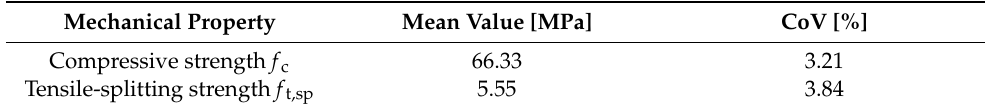
Table 2. Tested material properties of the concrete used in all tests. These material tests were performed on concrete cubes with the dimensions 100 × 100 × 100 mm 3 .